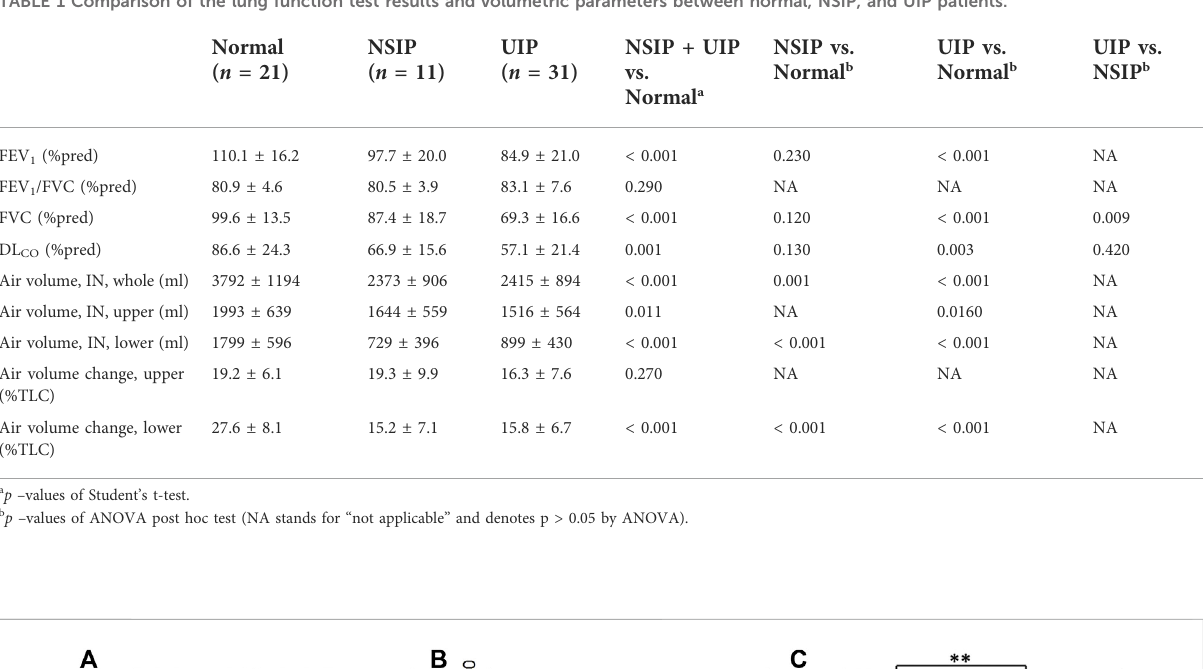
TABLE 1 Comparison of the lung function test results and volumetric parameters between normal, NSIP, and UIP